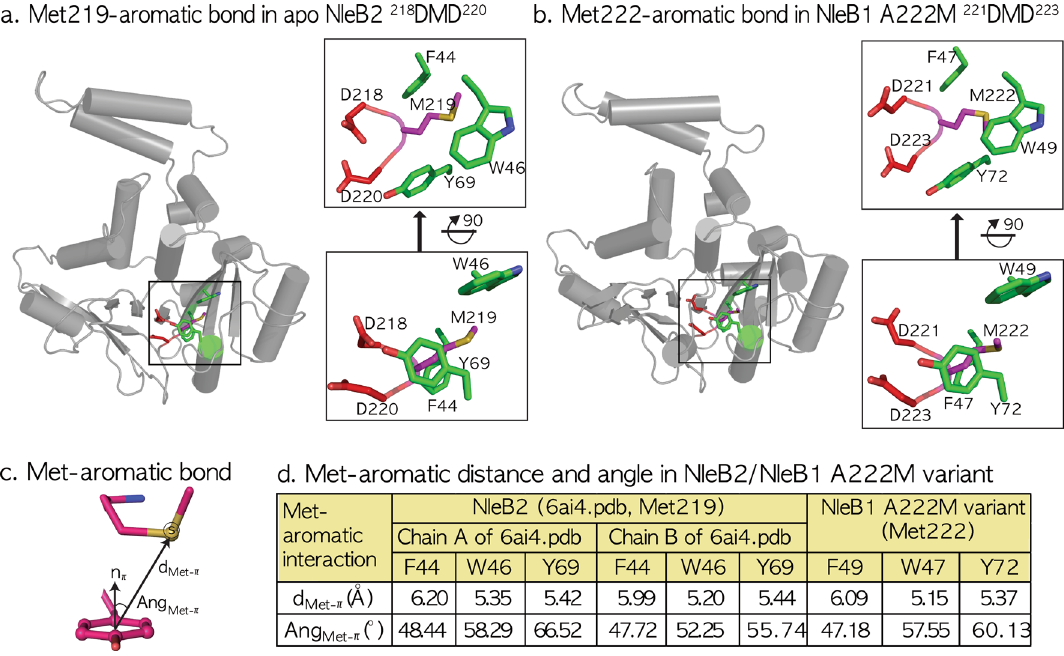
Figure 5. Met–aromatic interaction in NleB1/2 toxins and kinetic analysis of NleB1, NleB2, and their derivatives with FADD DD in the presence of UDP-Glc/GlcNAc. ( a ) Met219-aromatic interaction in apo NleB2. In the refined apo NleB2 structure, there are three aromatic residues, F44, W46, and Y69, near the methionine in the DxD (218DMD220) motif. ( b ) Met222-aromatic interaction in the NleB1 A222M variant. Substitution of Ala222 with Met222 in the wild NleB1 structure (6ACI) facilitates Met–aromatic interaction with the three aromatic residues, F47, W49, and Y72. ( c ) Met–aromatic bond. The Met–aromatic distance d Met–π is measured by the distance between the sulfur of the Met residue and the ring center of three aromatic residues, Phe, Tyr, and Trp, and the orientation angle, Ang Met–π is defined as the angle between the positional vector of sulfur from the ring center and the normal vector defined by the plane of the aromatic ring, as described in the “Methods”. ( d ) Met–aromatic distance and angle in NleB2/NleB1 A222M variant. All Met–aromatic interactions near the DxD motif were extracted as defined previously 32 , wherein the Met–aromatic energy is associated with both the distance d Met–π and the orientation angle, Ang Met–π between Met and three aromatic residues, Phe, Tyr, and